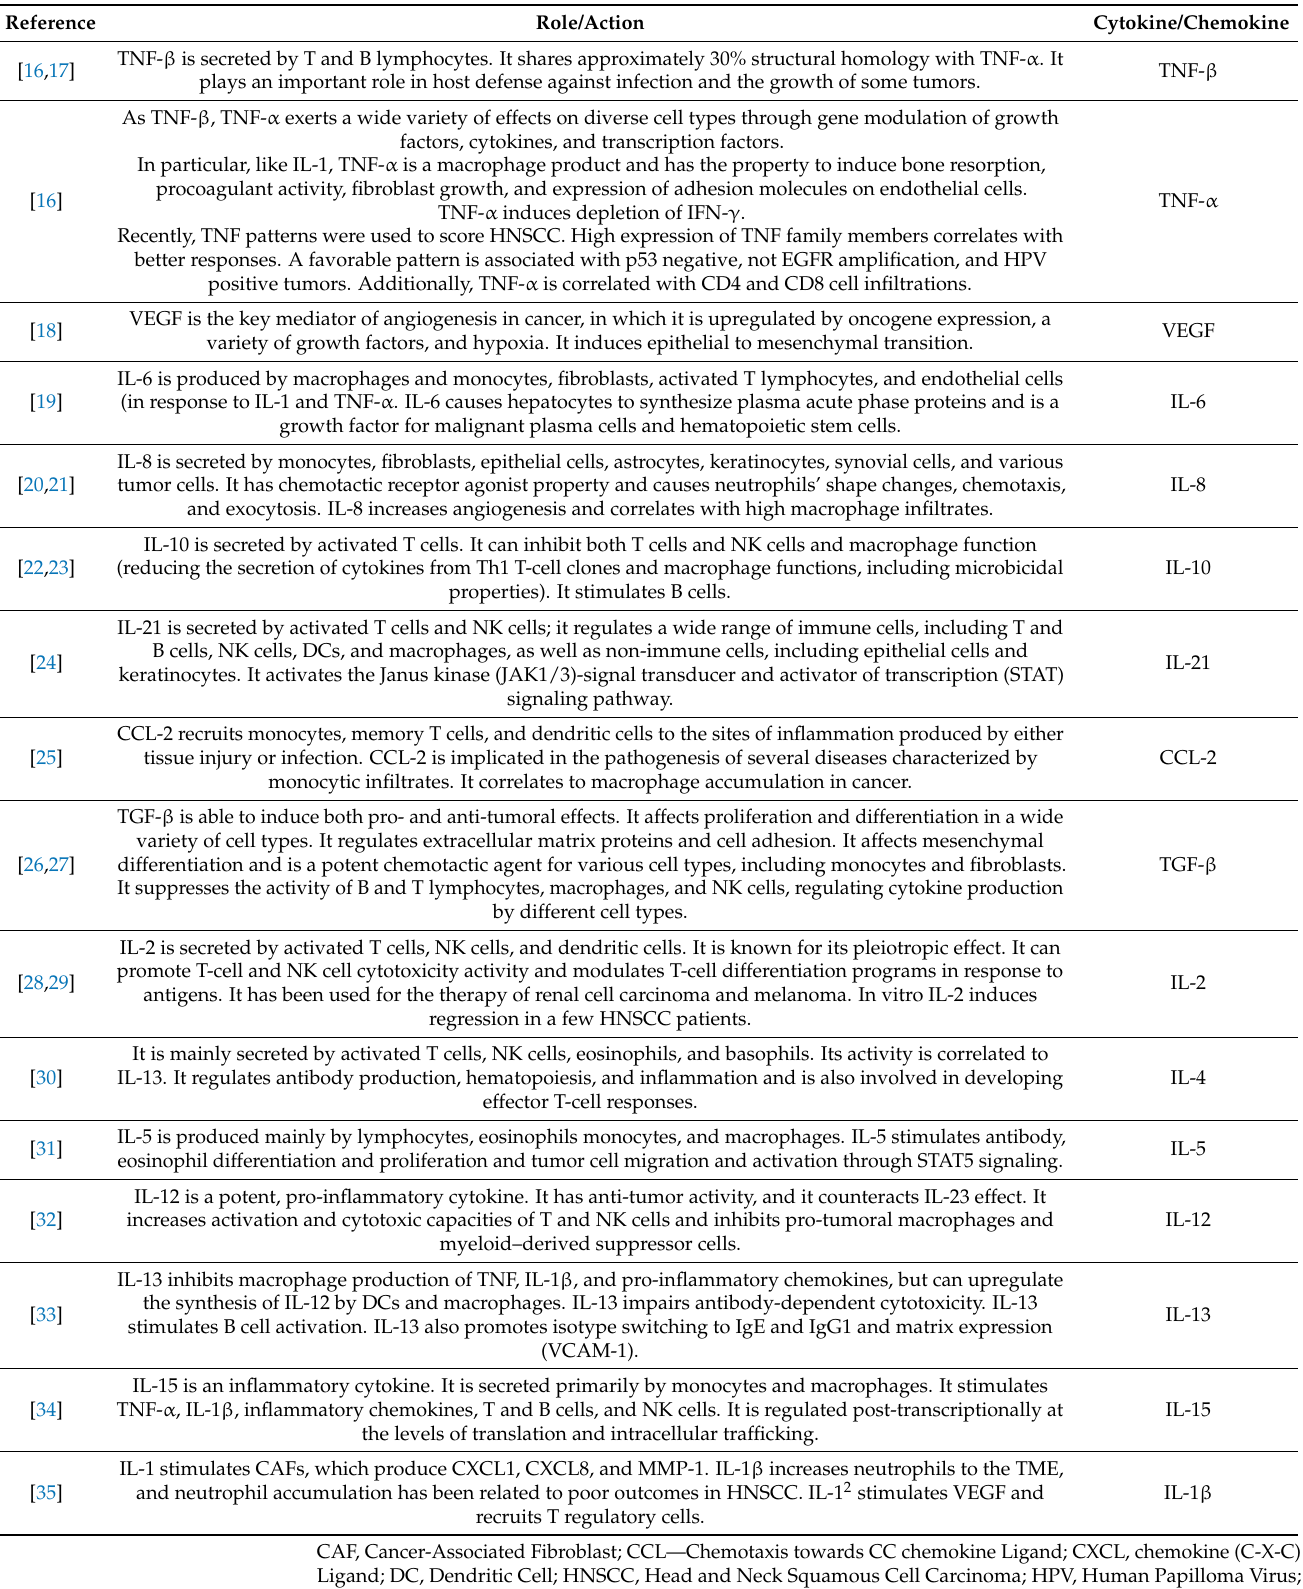
Table 1. Cytokines correlated to treatment response in solid tumors and